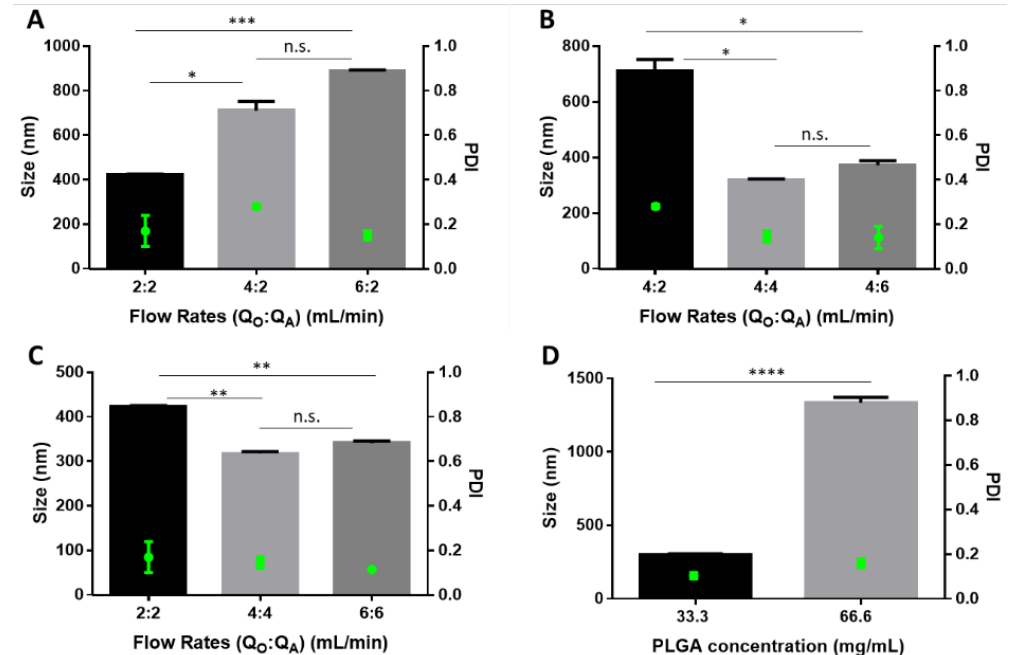
Figure 1. ( A – C ) Influence of process and formulation parameters on the particle size. The variation of particle size at different flow rates for 33.3 mg/mL PLGA as organic phase and 1% PVA as aqueous phase. ( D ) The influence of PLGA concentration on the particle size (organic:aqueous flow rate of 4:4 mL/min, 3% PVA as aqueous phase). Bars: intensity-averaged particle size; green dots: polydispersity